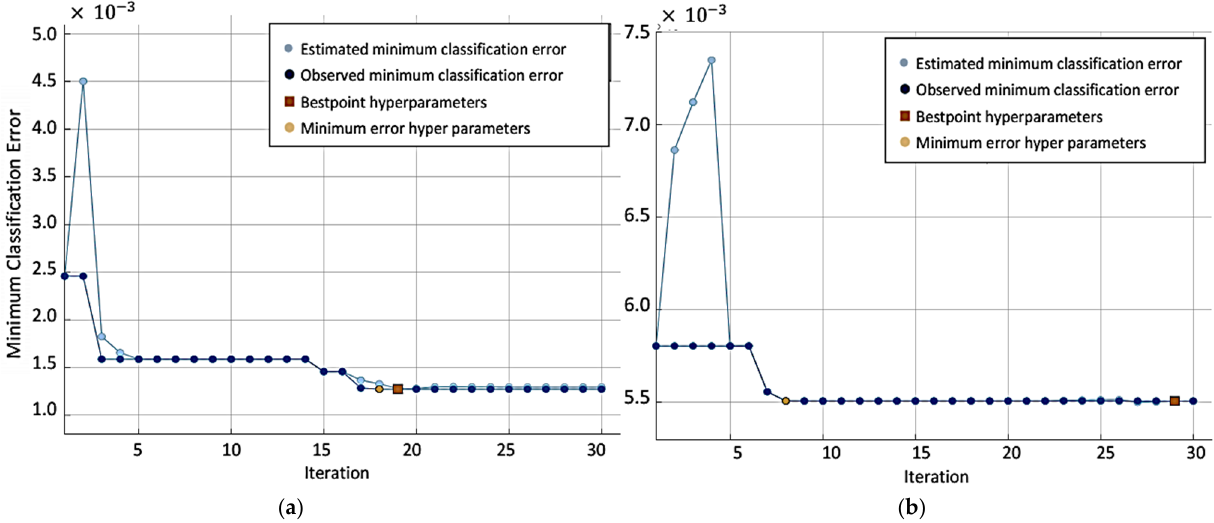
Figure 10. Performance analysis trajectories using the mean square cost: ( a ) ODT based detection system and ( b ) ODT-based classification system. Electronics 2021 , 10 , x FOR PEER REVIEW